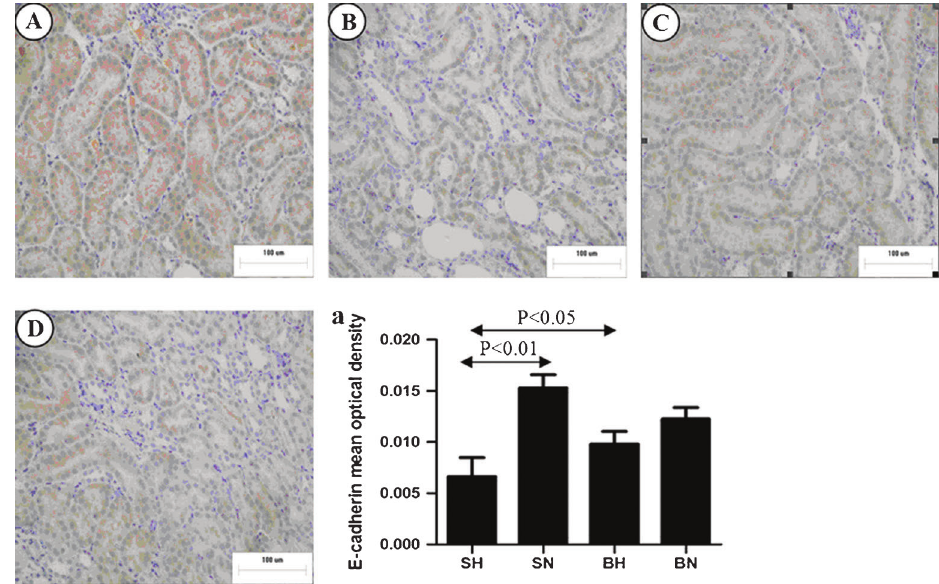
Figure 3. Representative images of immunostaining for E-cadherin in the renal medulla of all groups. A , SN group; B , SH group; C , BN group; D , BH group. a , Positive immunostaining of E-cadherin was quantified in renal medulla. SN: Dahl salt-sensitive (SS) rats on a